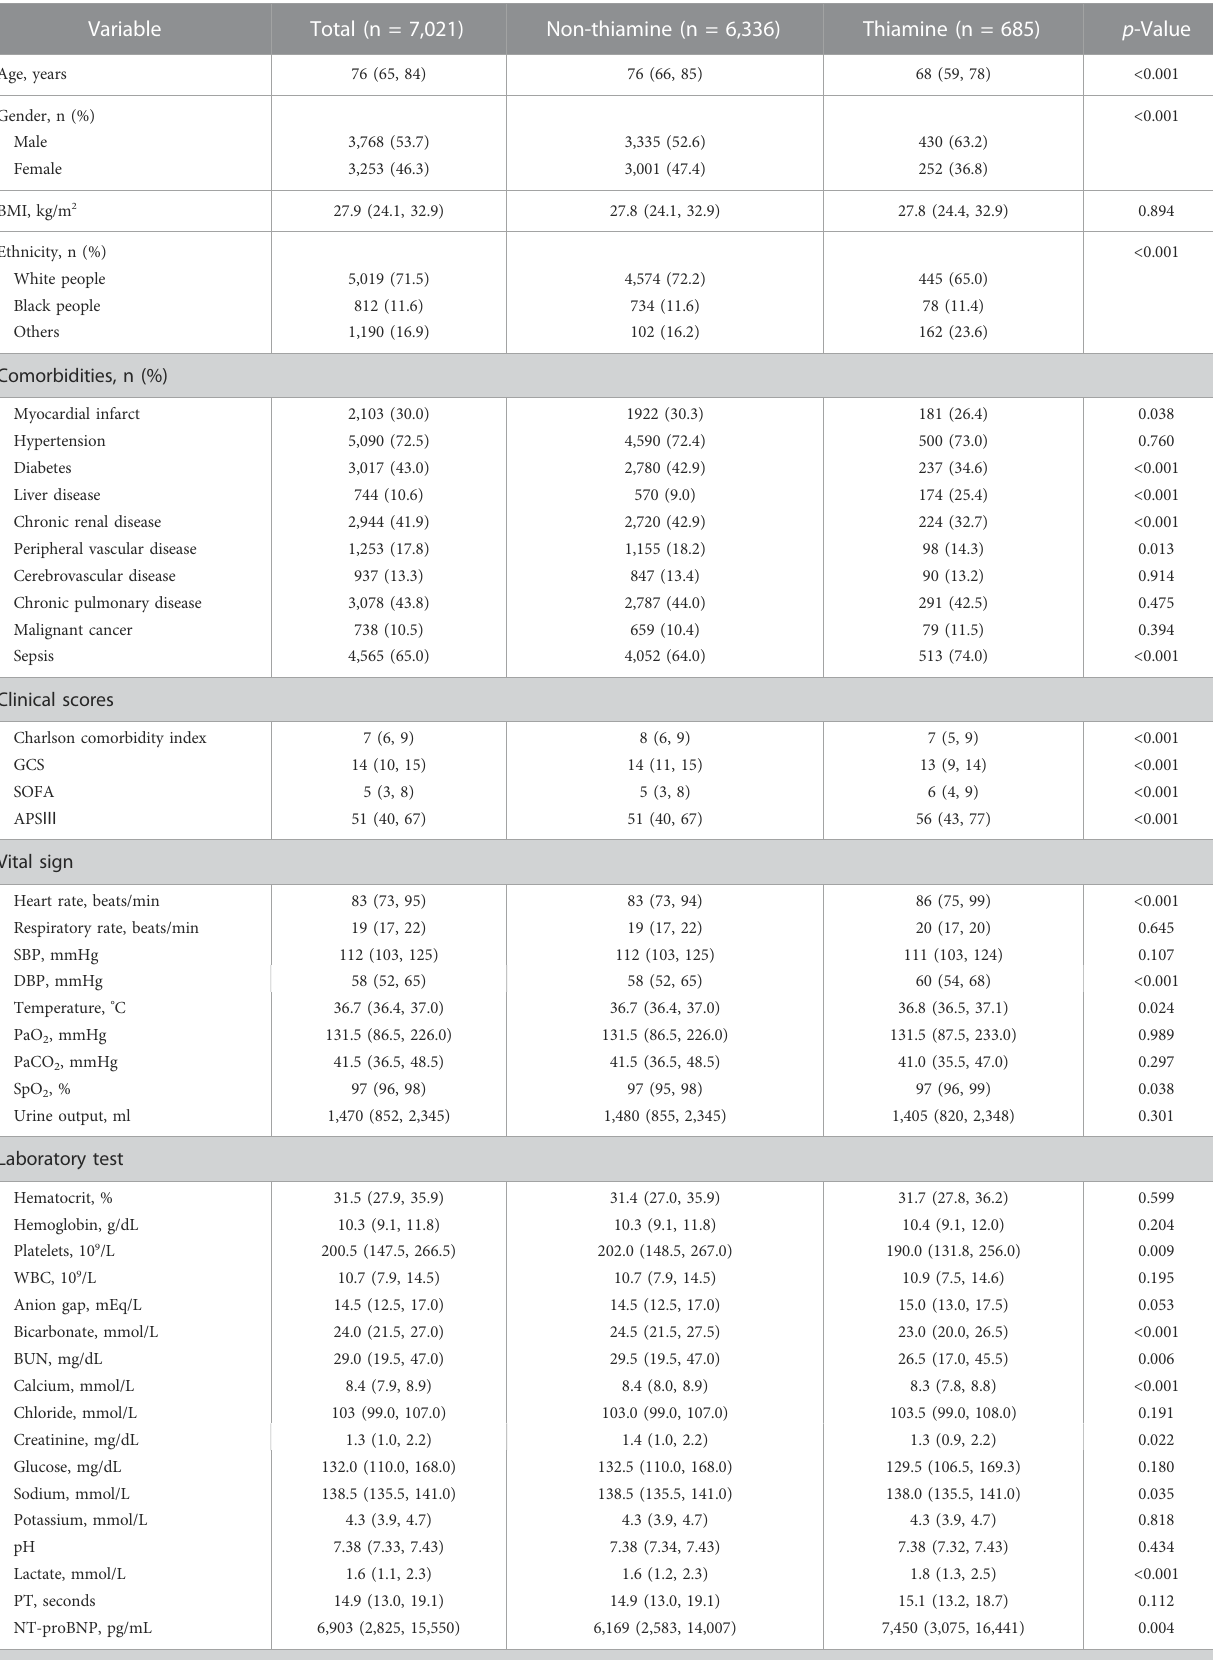
TABLE 1 Baseline features of the original